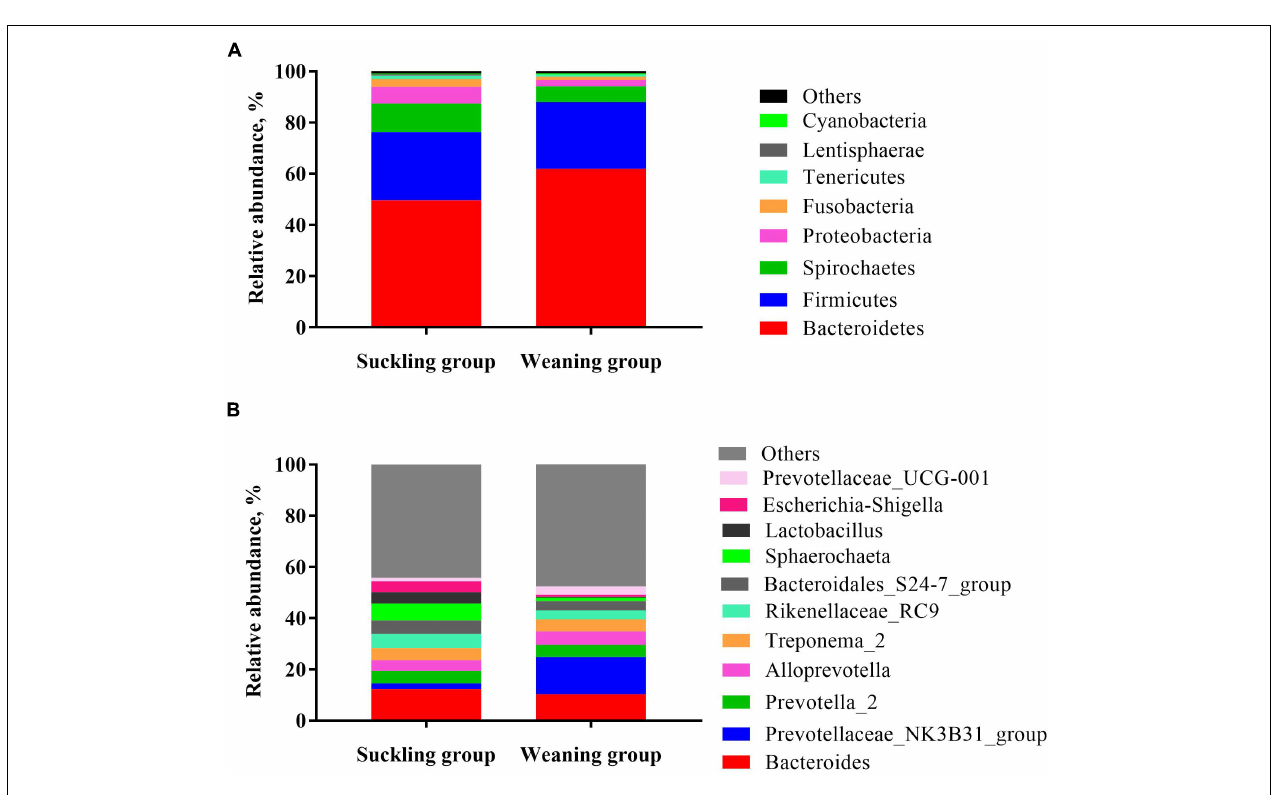
the concentrations of butyric acid ( P = 0.07), pentanoic acid ( P = 0.15), and isopentanoic acid ( P = 0.06) in the colonic digesta between the weaned and suckling